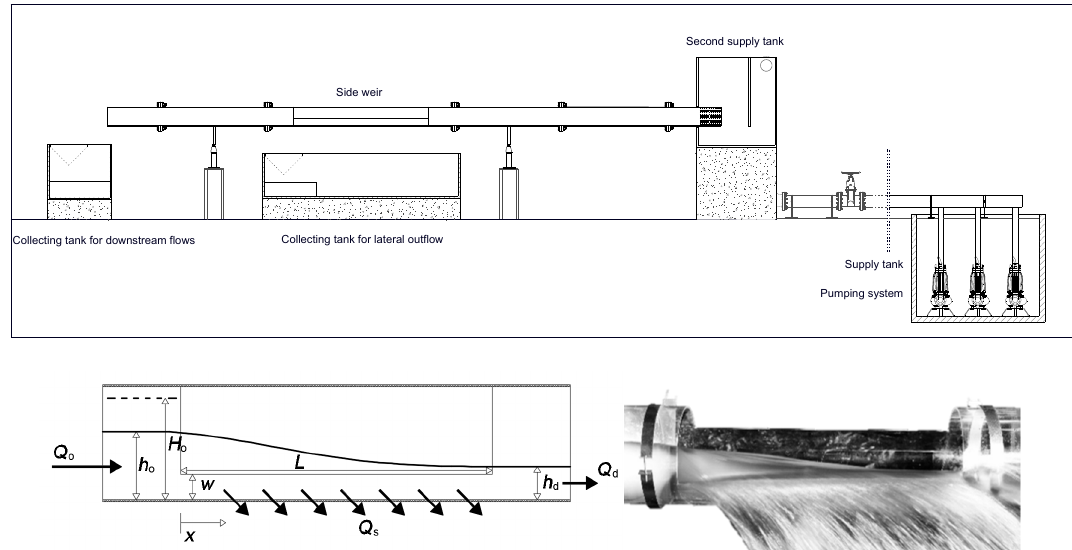
Figure 1. Experimental facility. Side weir sketch with symbols. Typical free surface on the side weir in supercritical flow.